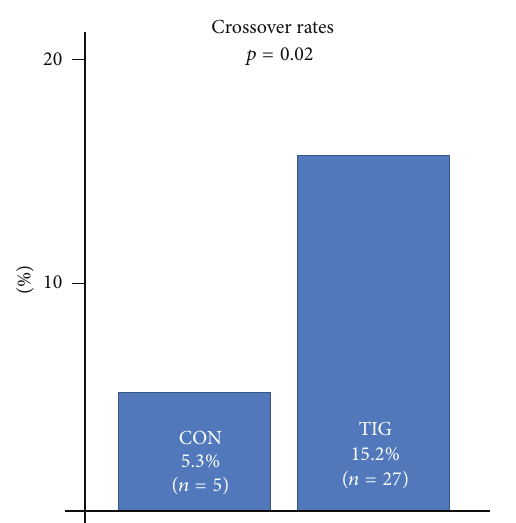
Figure 2: Crossover rates in conventional (CON) catheters versus radial (TIG)